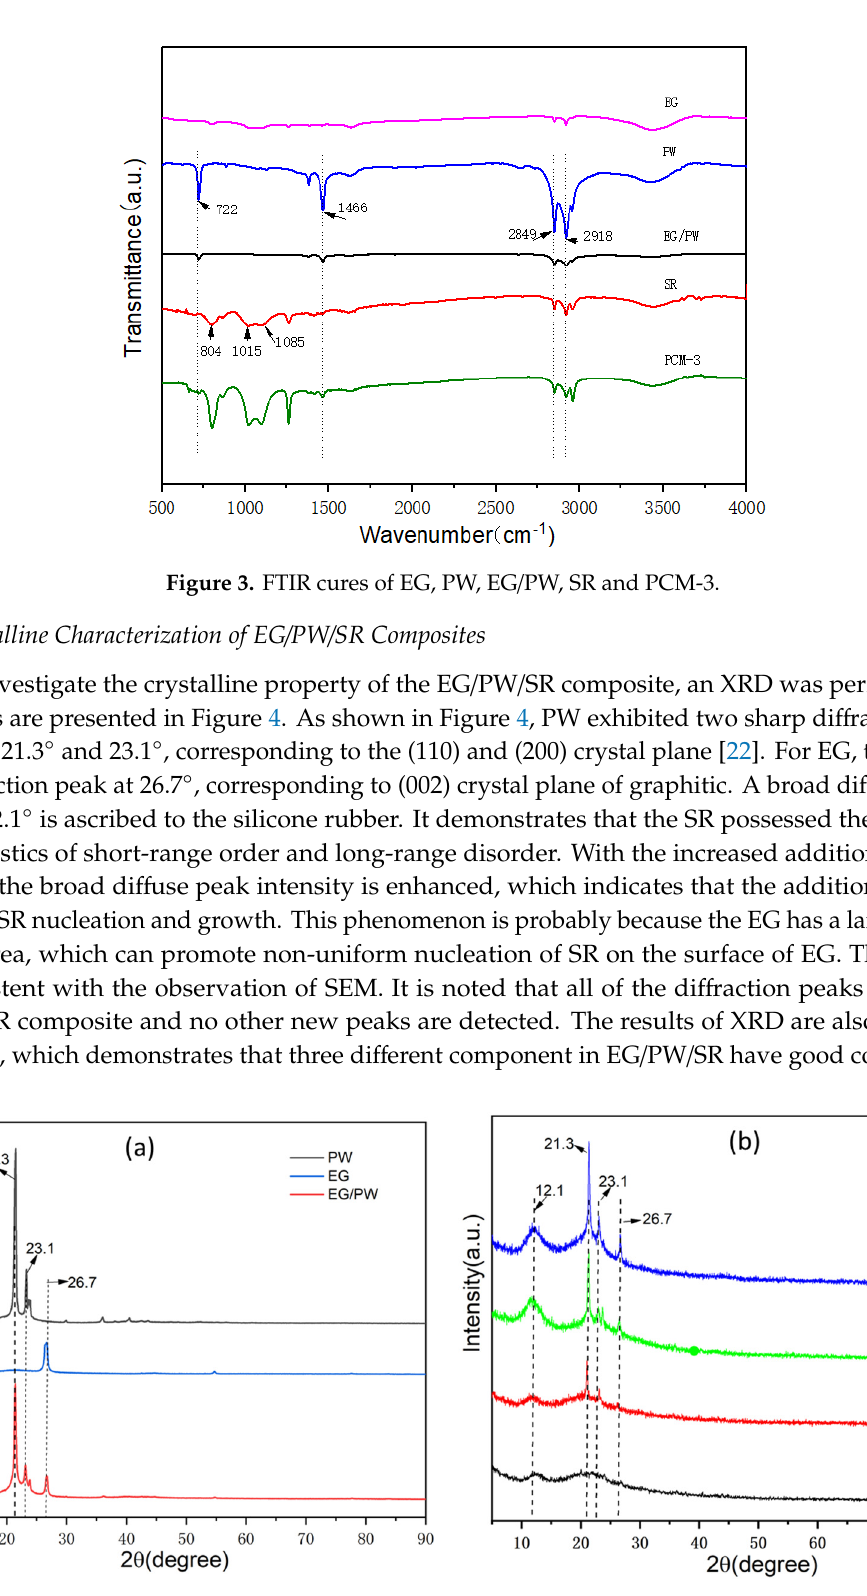
Figure 4. ( a ) XRD diagrams of PW, EG and EG/PW and ( b ) XRD diagrams of SR and as obtained EG/PW/SR composites.